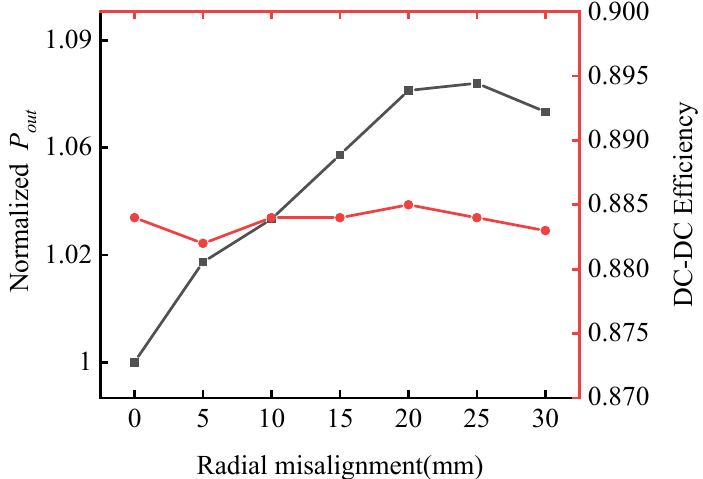
Figure 18. The output power and system efficiency varying with radial misalignments when h = 70 mm.